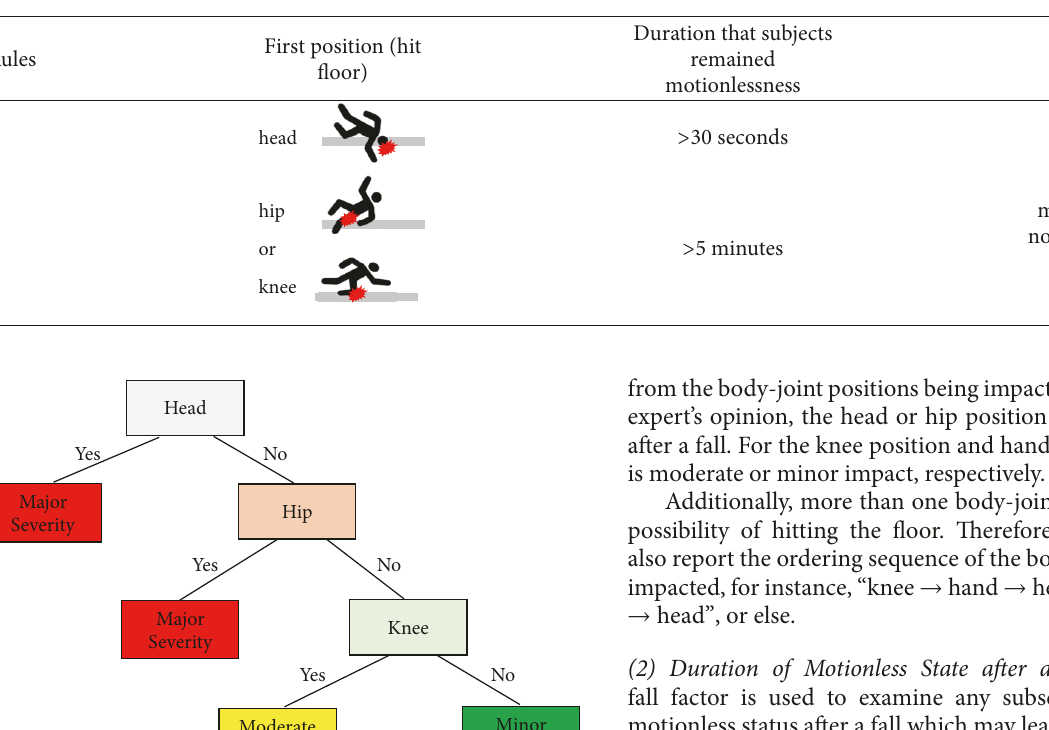
Table 1: Rules for examination of prolonged duration of motionlessness.